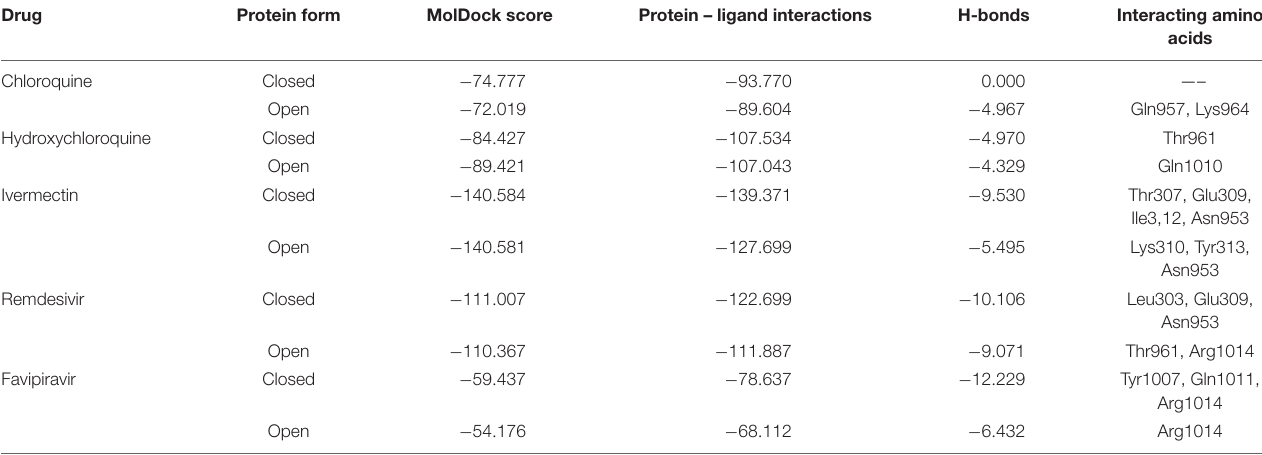
TABLE 1 | Docking of the SARS-CoV-2 spike protein (PDB id = 6VXX) to selected drugs. Drug Protein